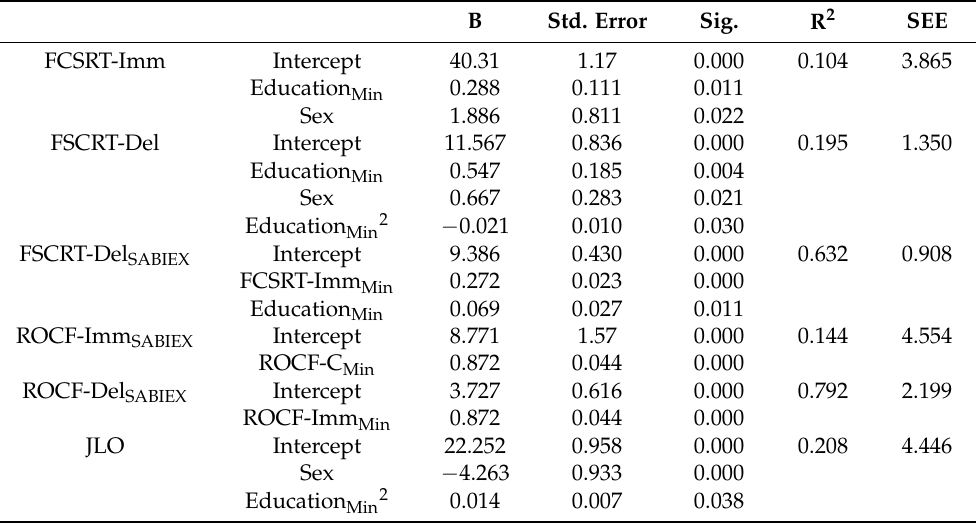
Table 2. Multiple linear regression models.